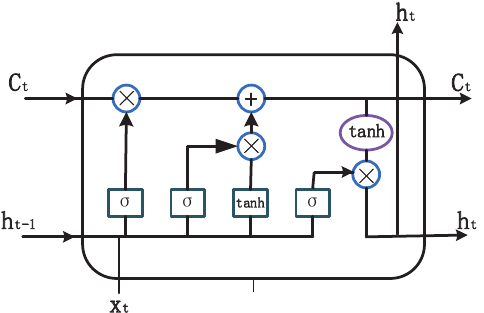
Figure 3. Long Short Term Memory (LSTM) model structure. C t is the cell state and h t is the hidden state. σ represents the sigmoid activation function and tanh represents the tanh activation function. ⊗ means the element-wise product and ⊕ means concatenation